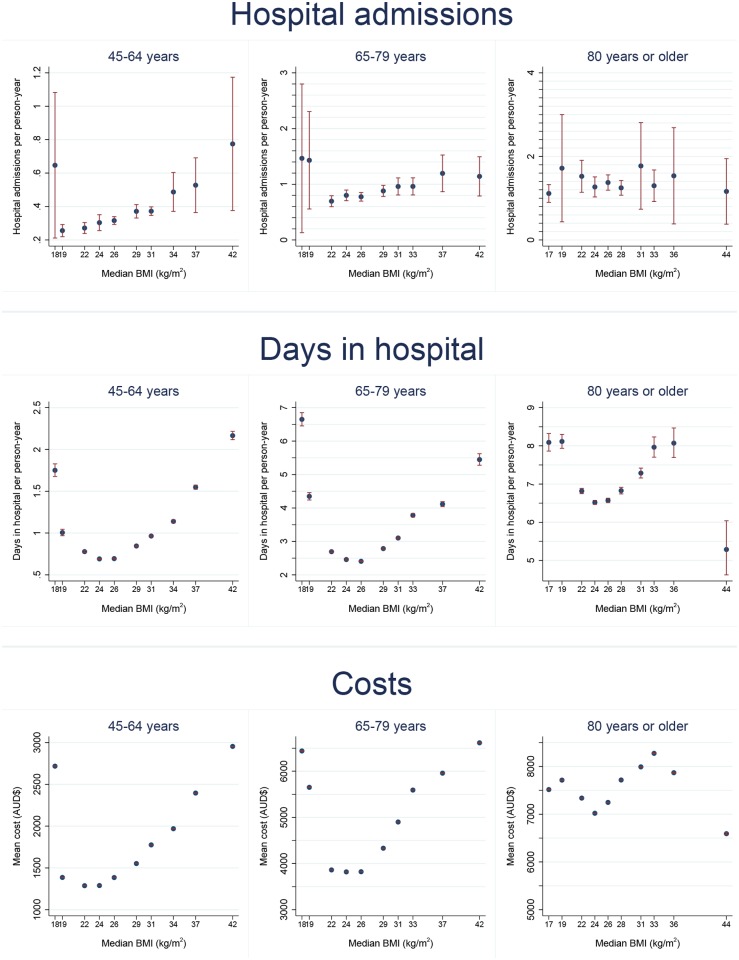
Age-standardised hospital admissions, days in hospital and costs per person-year (with 95% CIs) by body mass index (BMI), males.Notes. 1. Within each age group, rates are age-standardised to the 2006 NSW population (in 5 year age-groups) using the direct method.